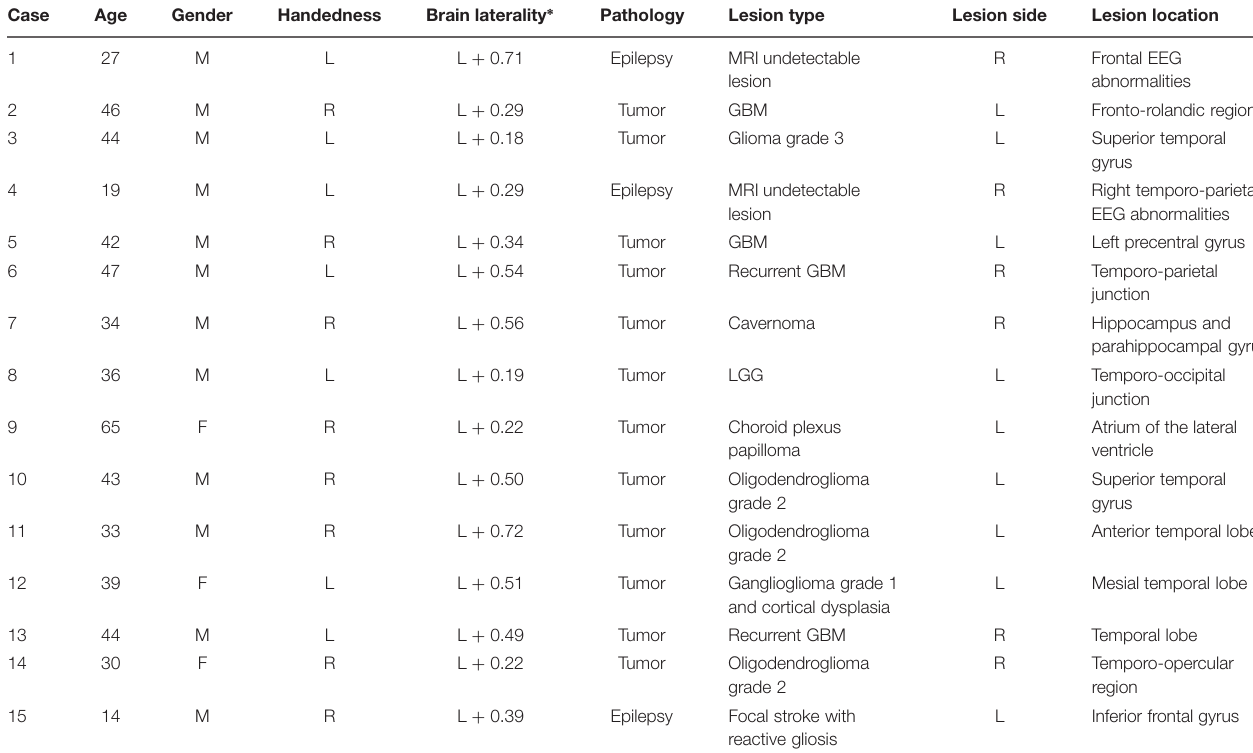
TABLE 1 | Patient demographic and clinical